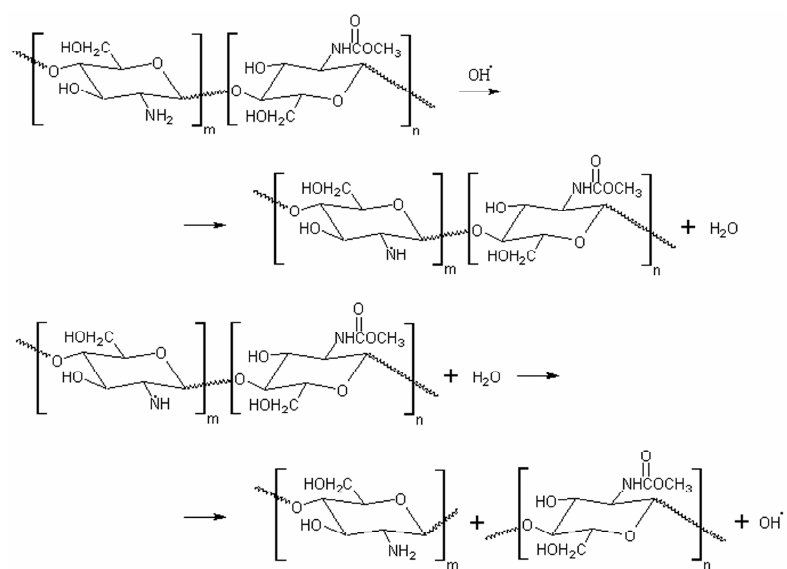
Figure 10. The scheme of chitin degradation under hydroxyl radical action in the EBP: the attack of OH radicals on the chitin –NH 2 groups [32].